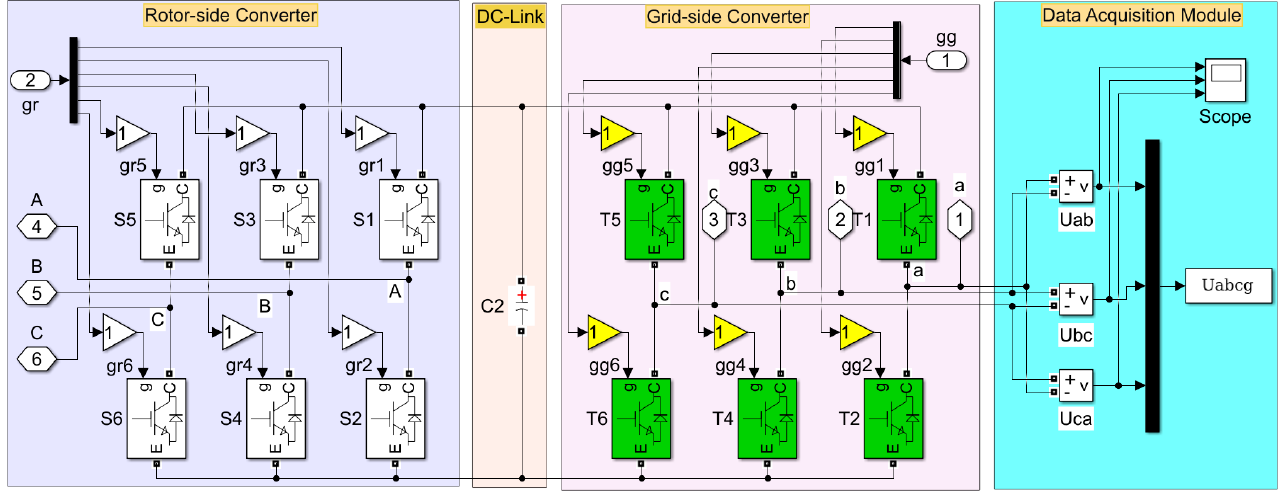
Figure 4. Simulation model of the converter.